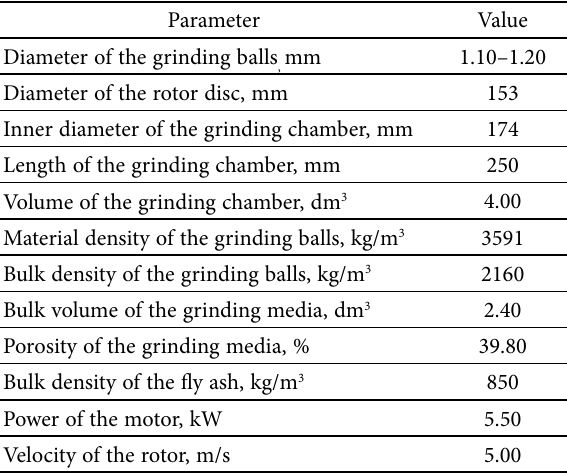
Table 3. Operating parameters of the stirred media mill Parameter Value Diameter of the grinding balls ,